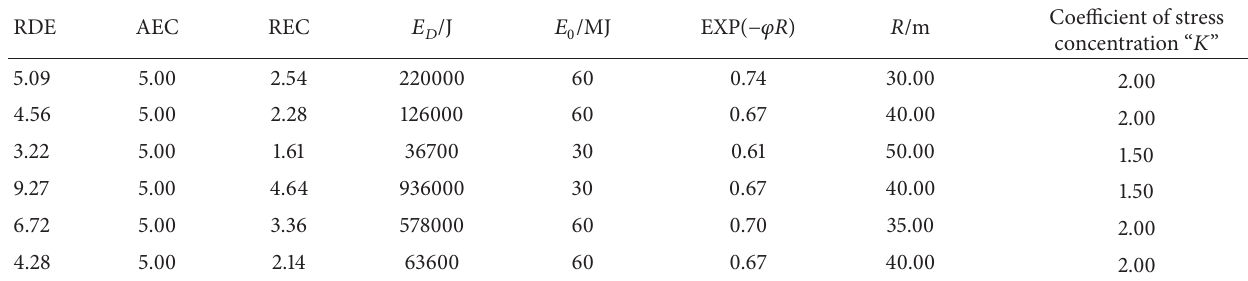
Table 4: Statistics of previous rockburst in Junde coal mine.